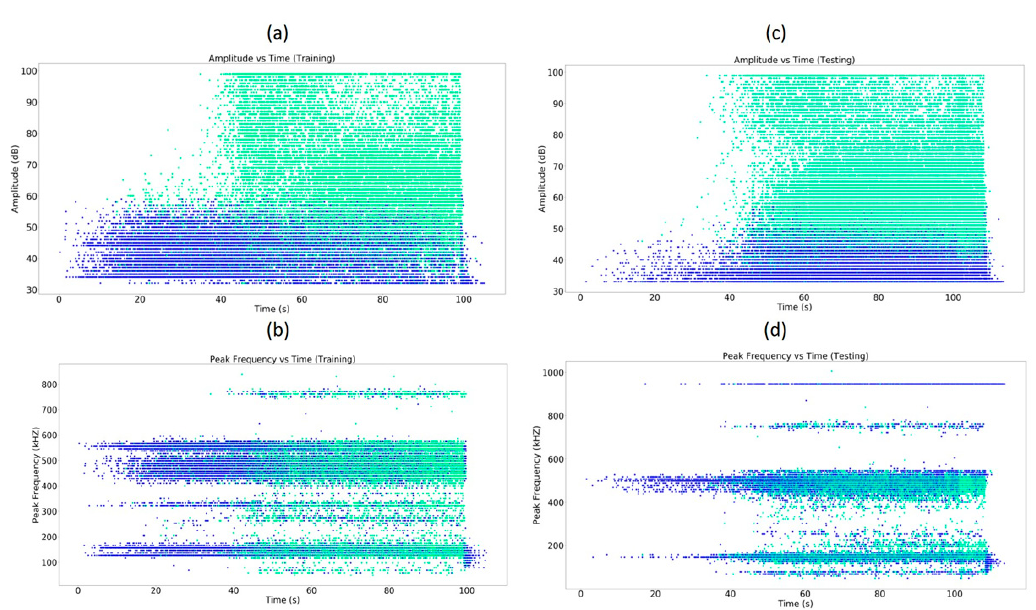
Figure 7. Criteria used for cluster assessment.